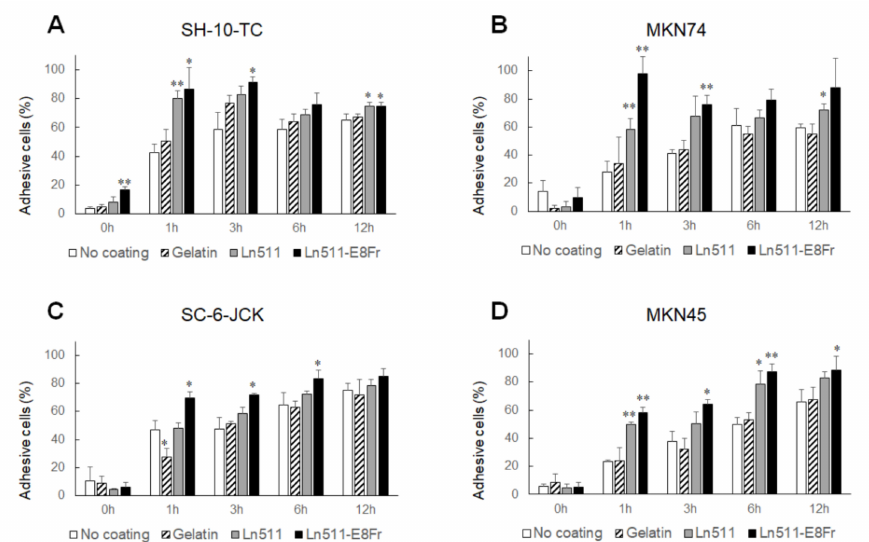
Figure 6. Results of cellular adhesiveness. Adhered cells were determined by the MTT/MTS assay. The percentages of adhesive SH-10-TC ( A ), MKN74 ( B ), SC-6-JCK ( C ), and MKN45 cells ( D ) were highest on the Ln511-E8 fragment. These results indicate the superior affinity interactions between gastric cancer cells and the Ln511-E8 fragment, rather than full-length Ln511. * p < 0.05, ** p < 0.01, as indicated (vs. no coating). Data are presented as the mean ± standard deviation of three independent